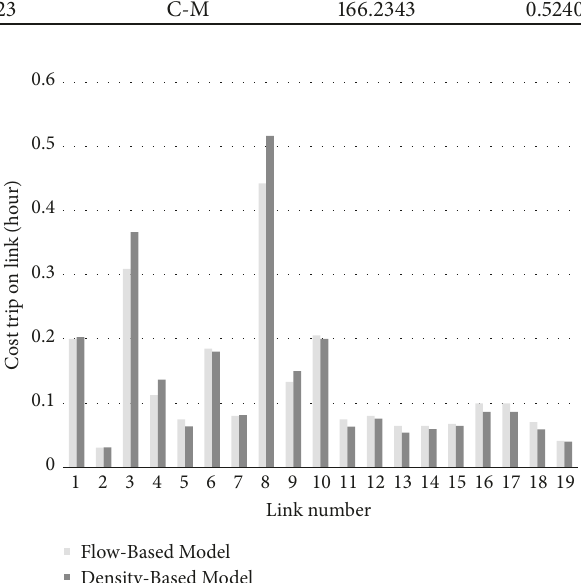
Figure 8: Link Costs, Both Approaches (low congestion).